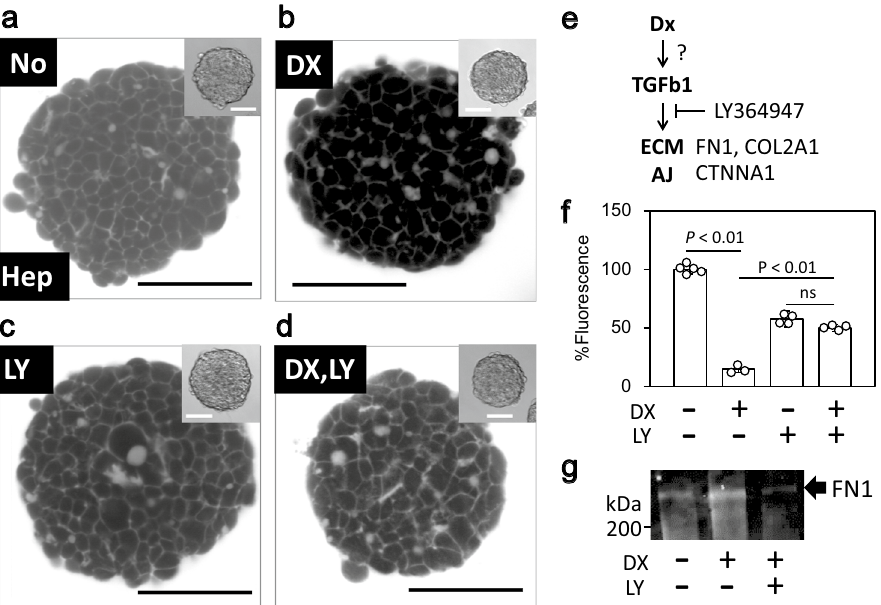
Figure 4. Doxorubicin reduces fluorescent dye diffusion into the HepG2 spheroid core region by the TGF-β– ECM signaling cascade. ( a – d ) Representative confocal image of living HepG2 spheroids treated with DX, LY (LY364947, TGF-β inhibitor), or both. ( b ) Shows a darker core than ( a ); ( c , d ) contain higher intensity of fluorescence than ( b ). Bar: 100 µm. Inset: bright field. Bar: 50 µm. ( e ) Simplified schema of TGF-β signaling cascade with related genes. TGFB1: TGF-β 1, FN1: fibronectin 1, COL2A1: collagen 2A1, CTNNA1: catenin A1, AJ, adherent junctions. ( f ) Quantitative analysis of the fluorescent intensity in confocal images of the target spheroid in ( a – d ). N = 5 (DX−/LY−); 4 (DX−/LY+); 3 (DX+/LY−); 4 (DX+/LY+). ( g ) Immunoblotting for fibronectin on the drug-treated spheroids. DX induces FN1 expression and LY suppresses the effect. The entire blot with membrane edges visible is shown in Extended Data Figure